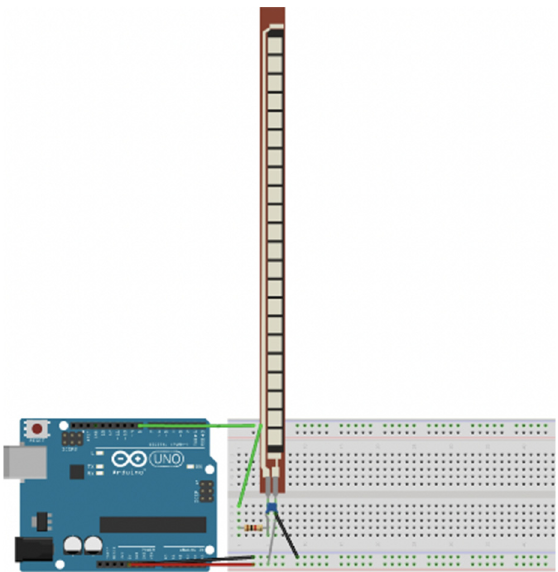
Figure 3. A simple interconnection of the fl ex sensor with the Arduino microcontroller.